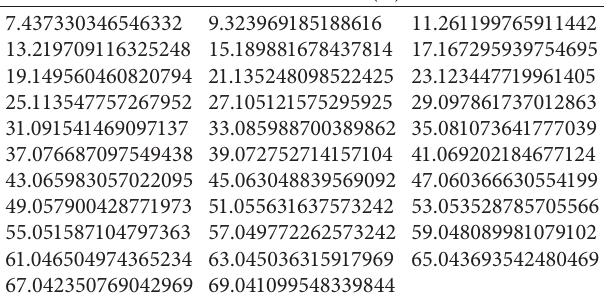
Table 1: Solution of P ( N ) �